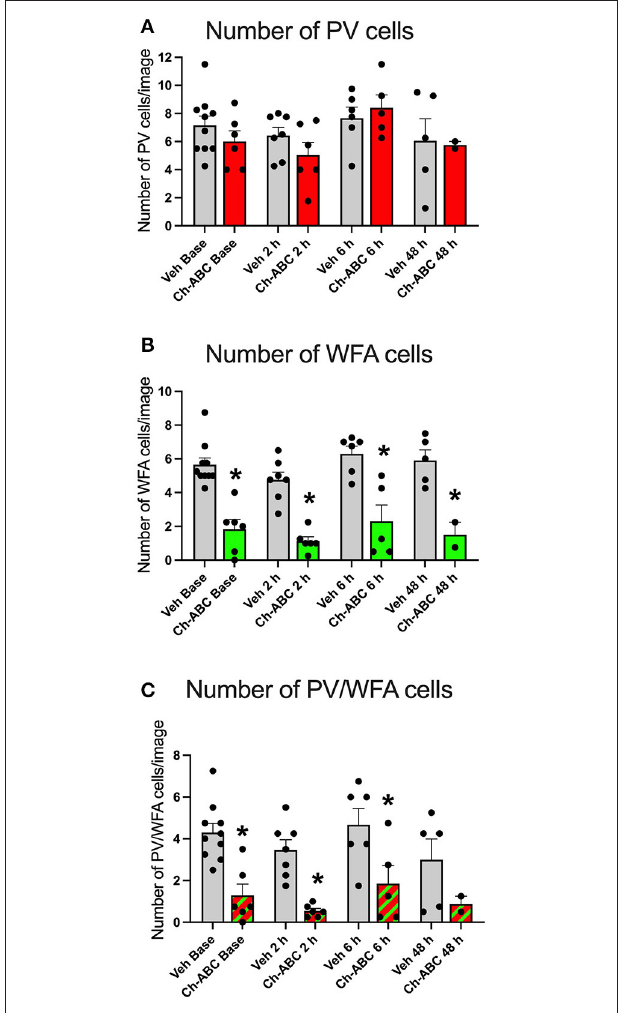
FIGURE 3 | Cocaine-primed reinstatement does not alter the number of PV or WFA cells in the prelimbic PFC. (A) Number of PV cells in prelimbic PFC. (B) Number of WFA cells in prelimbic PFC; WFA cell number decreased in Ch-ABC treated animals at baseline, 2, 6, and 48h compared to vehicle. (C) Number of PV/WFA double labeled cells in prelimbic PFC; PV/WFA cell number decreased at baseline, 2h, and 6h compared to vehicle. Bars show mean ± SEM, and individual data points depict the mean number of cells per rat across four images; N-sizes are as in Figure 2 . * P < 0.05 compared to vehicle group at the same time